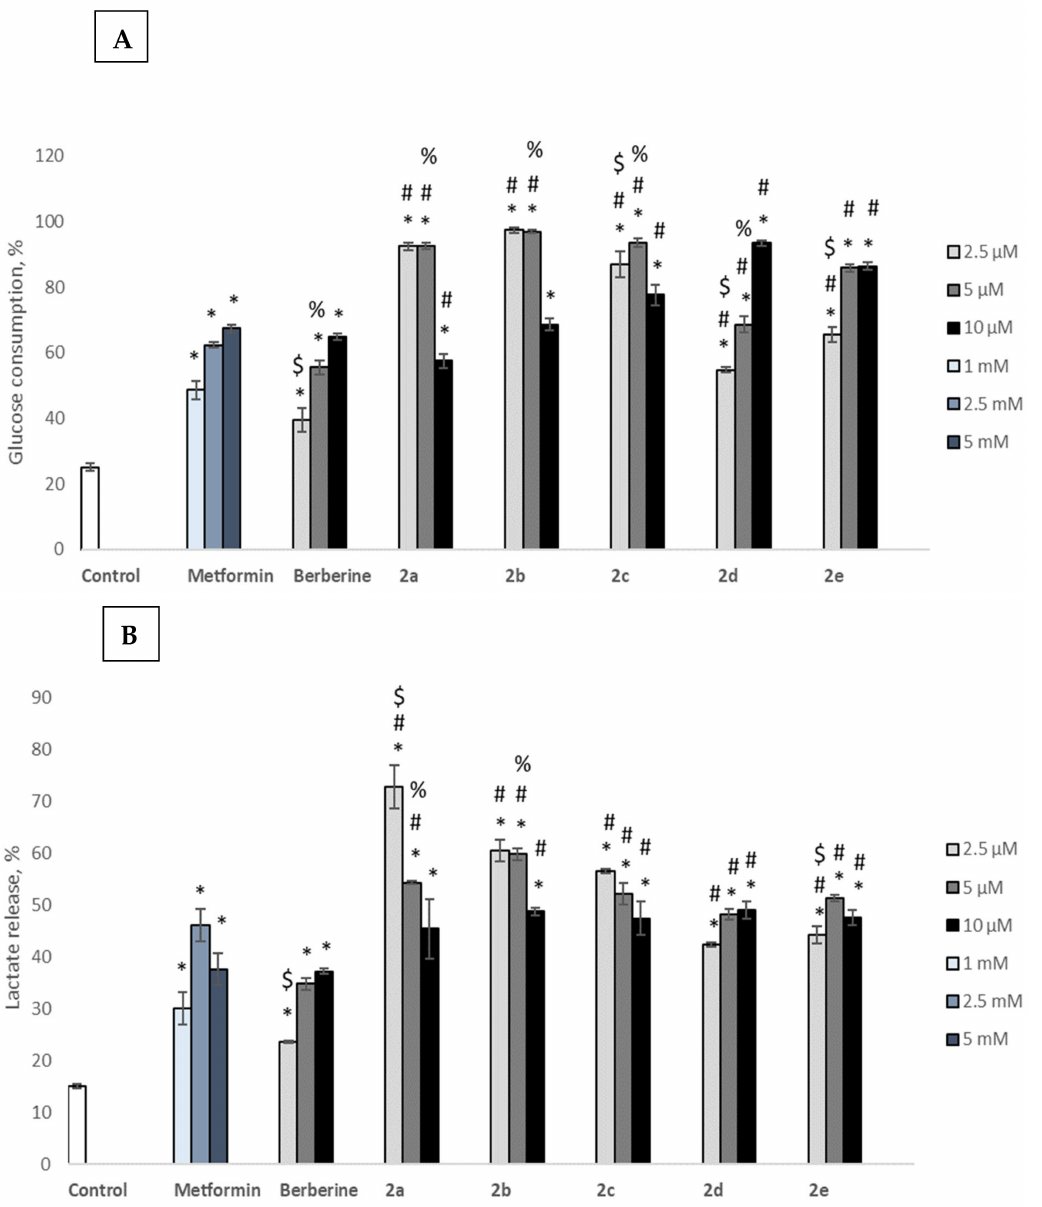
Figure 1. Glucose consumption ( A ) and lactate release ( B ) in HepG2 cells. * p < 0.5 as compared to control, # p < 0.05 as compared to berberine in a same dose, $ p < 0.05 2.5 µ M as compared to 5 µ M, % p < 0.05 5 µ M as compared to 10 µ M.